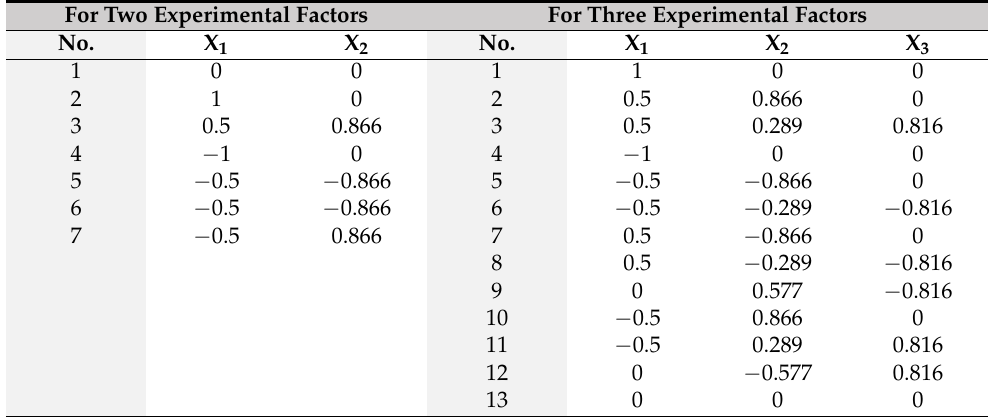
Table 8. The matrix of Doehlert design with two and three factors. For Two Experimental Factors For Three Experimental